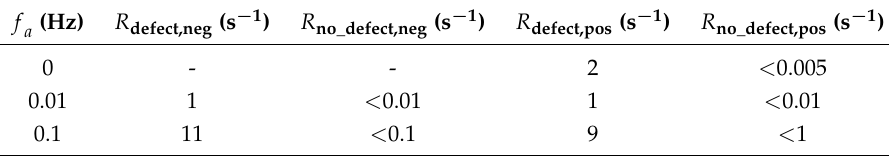
Table 1. PD repetition rate for cable with (a) defect (Negative: R defect,neg , Positive: R defect,pos ) (b) no defect (Negative: R no_defect,neg , Positive: R no_defect,pos ) with different frequencies at 20kV voltage.